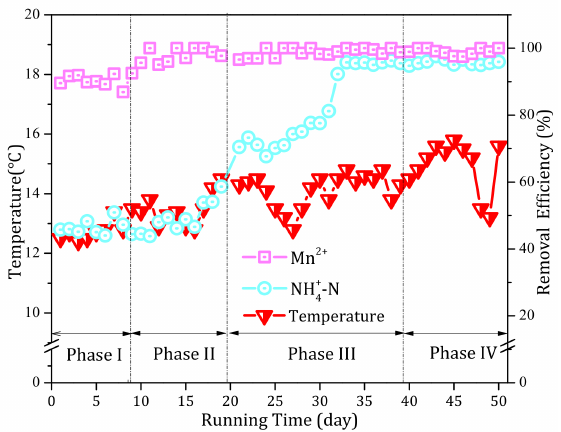
Figure 6. Profiles of the influent temperature during the continuous operational period of the pilot filter